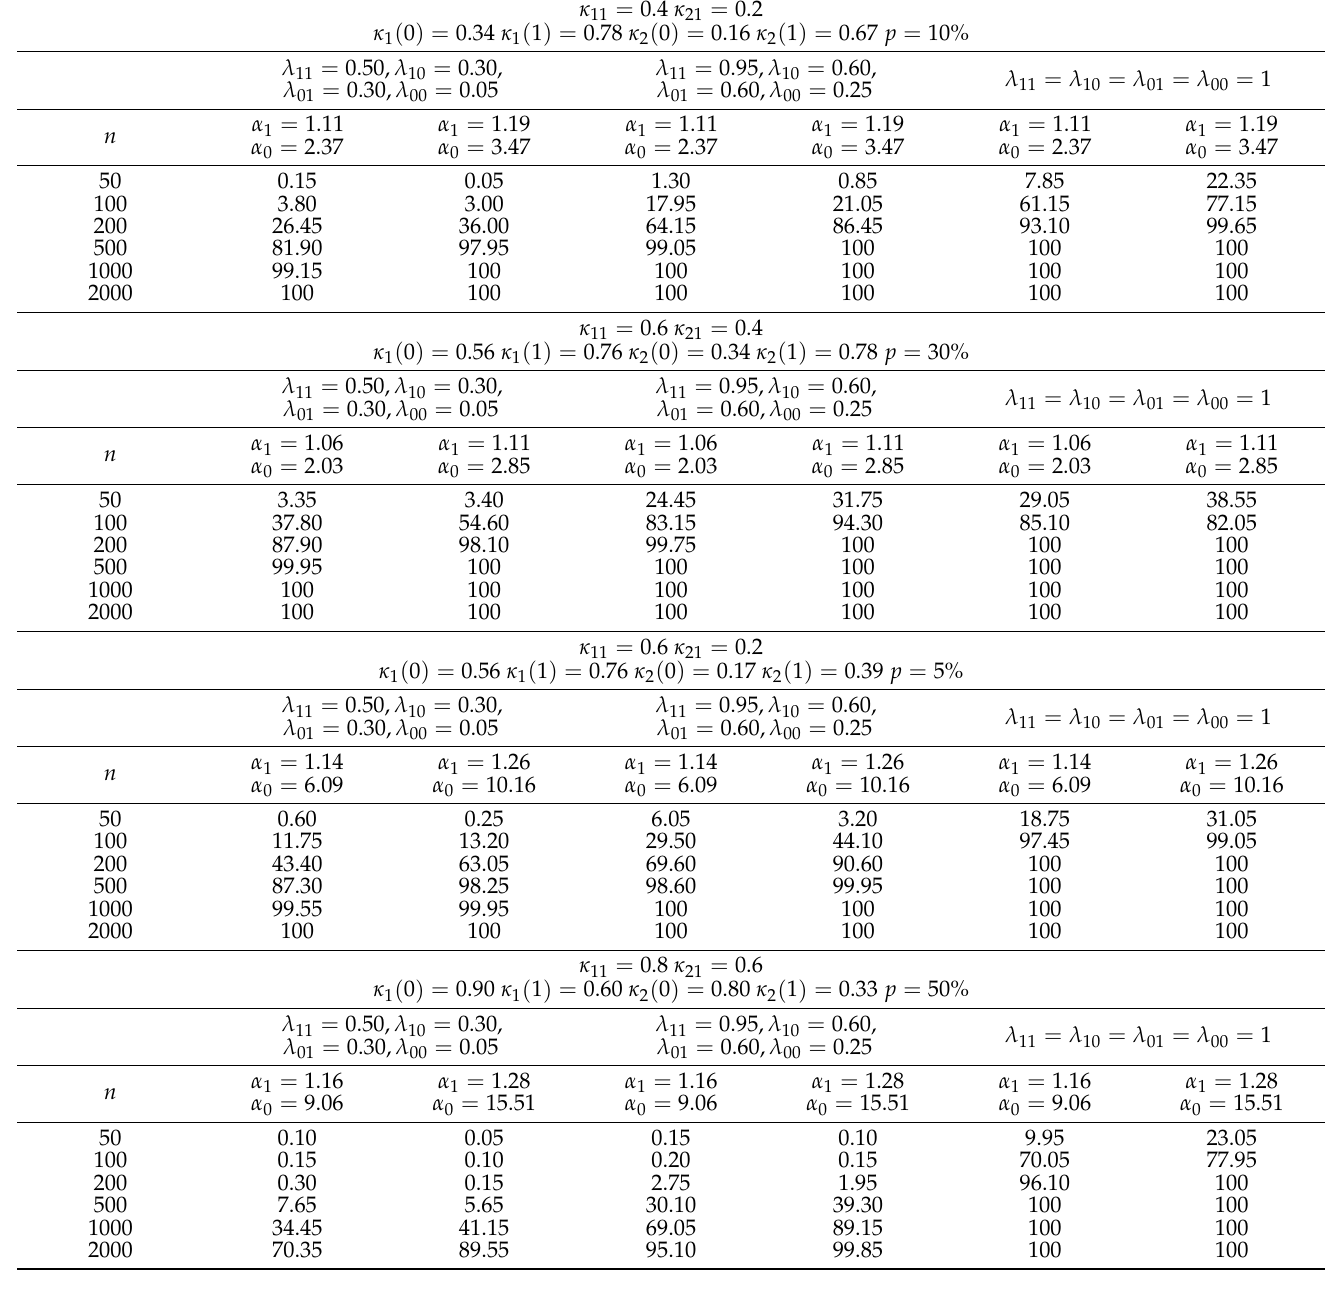
κ 11 = 0.4 κ 21 = 0.2